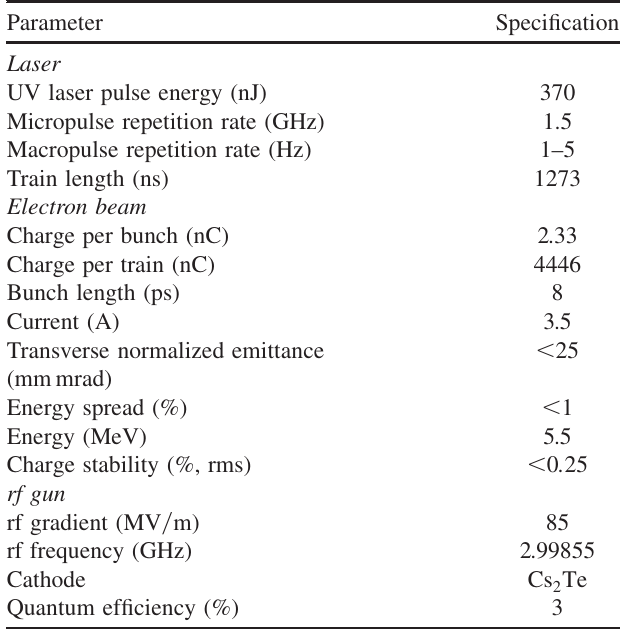
TABLE I. The specifications for the PHIN photoinjector. Parameter